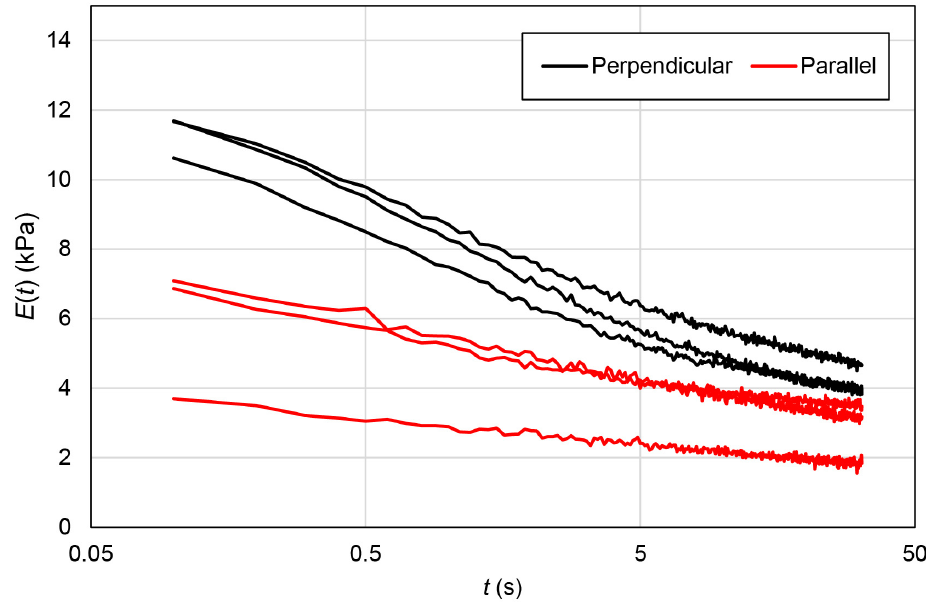
Figure 6. Relaxation moduli of the EMT in the perpendicular and parallel directions. All measured results are summarized in the figure ( n = 3).